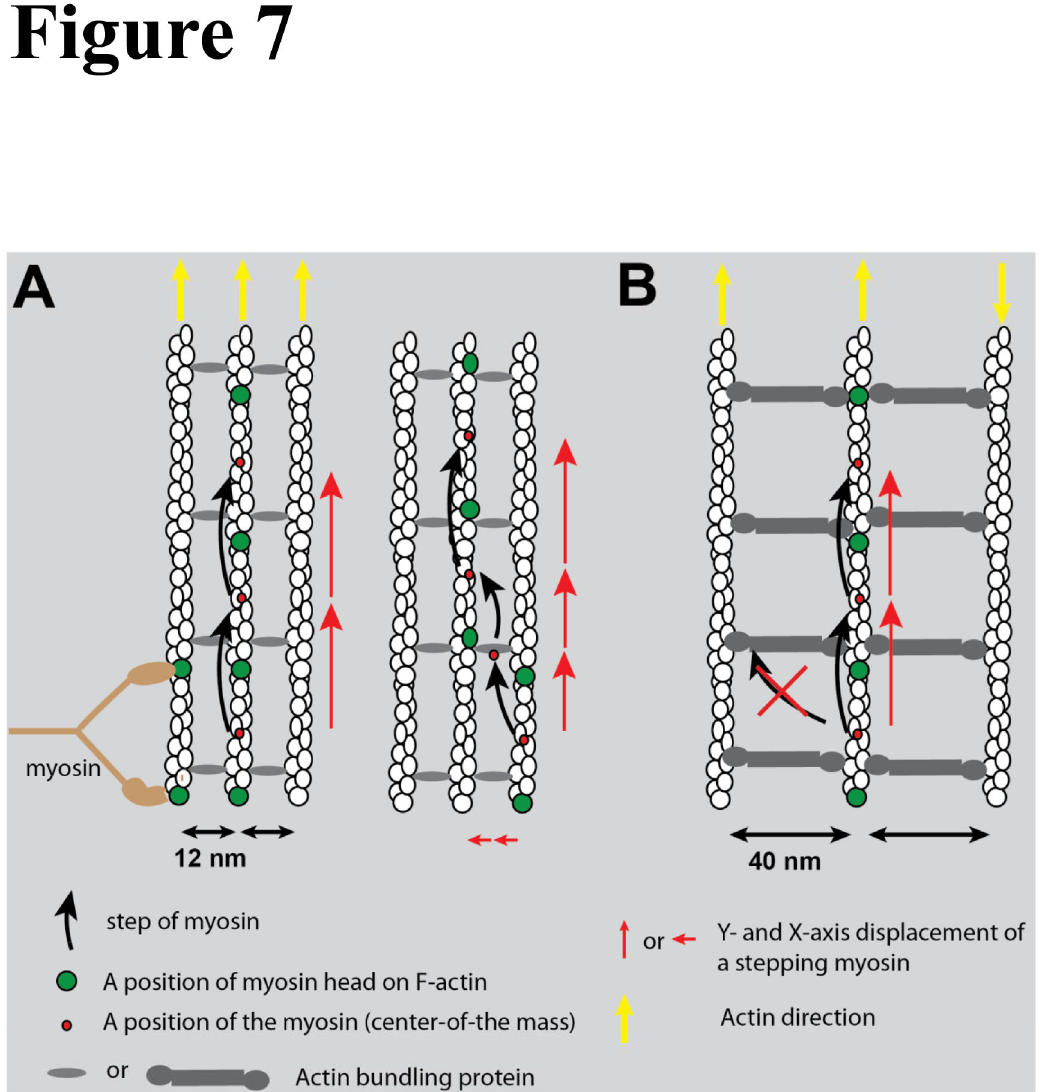
Figure 7. Stepping model of myosin on actin rafts. Myosin stepping model on F-actin rafts. Two heads of myosin (light brown color) bind on an actin monomer (green) in actin filaments. The center of the mass of the myosin is depicted by a red circle. When myosin steps forward (black arrow), the detached head binds a new actin monomer (green). (A) The model for stepping on fascin-F- actin rafts. Left-hand side shows the myosin molecule stepping forward along an actin filament in the rafts. The length of the red arrow represents the magnitude of the step-size. Black arrows represent the direction of the stepping. Right-hand side model shows a myosin molecule taking a side step to an adjacent actin filament in the rafts. Note that when a myosin takes a side step onto an adjacent actin filament the center of mass movement takes two short steps. Yellow arrow represents the direction of actin filament in the rafts. (B) The model of stepping on α-actinin-F-actin rafts. A myosin molecule cannot reach an adjacent actin filament and thus cannot have a side